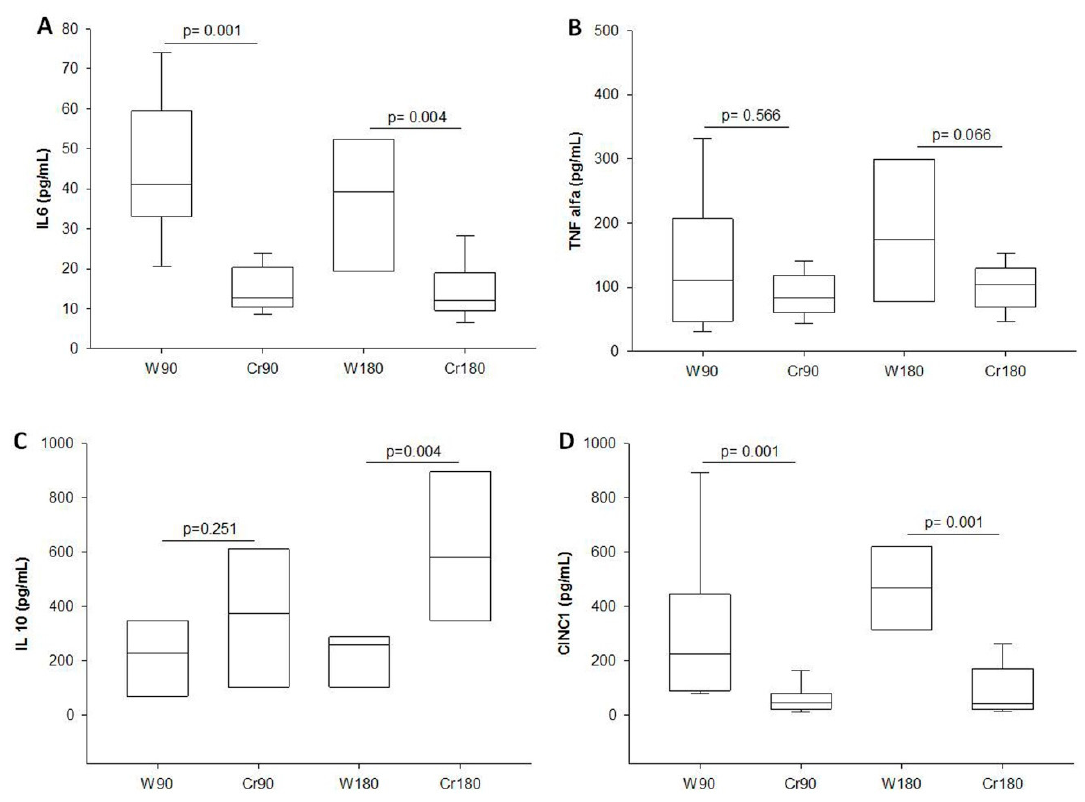
Figure 7. Pro and anti-inflammatory cytokines in the BALF (pg / mL). W90, control / water + 90 min of ischemia; Cr90, creatine + 90 min of ischemia; W180, control / water + 180 min of ischemia; Cr180, creatine + 180 min of ischemia. ( A ) Interleukin 6; ( B ) tumor necrosis factor-alpha; ( C ) interleukin 10; ( D ) cytokine-induced neutrophil chemoattractant 1. Data are expressed as median and interquartile range ( n = 8 animals / group).